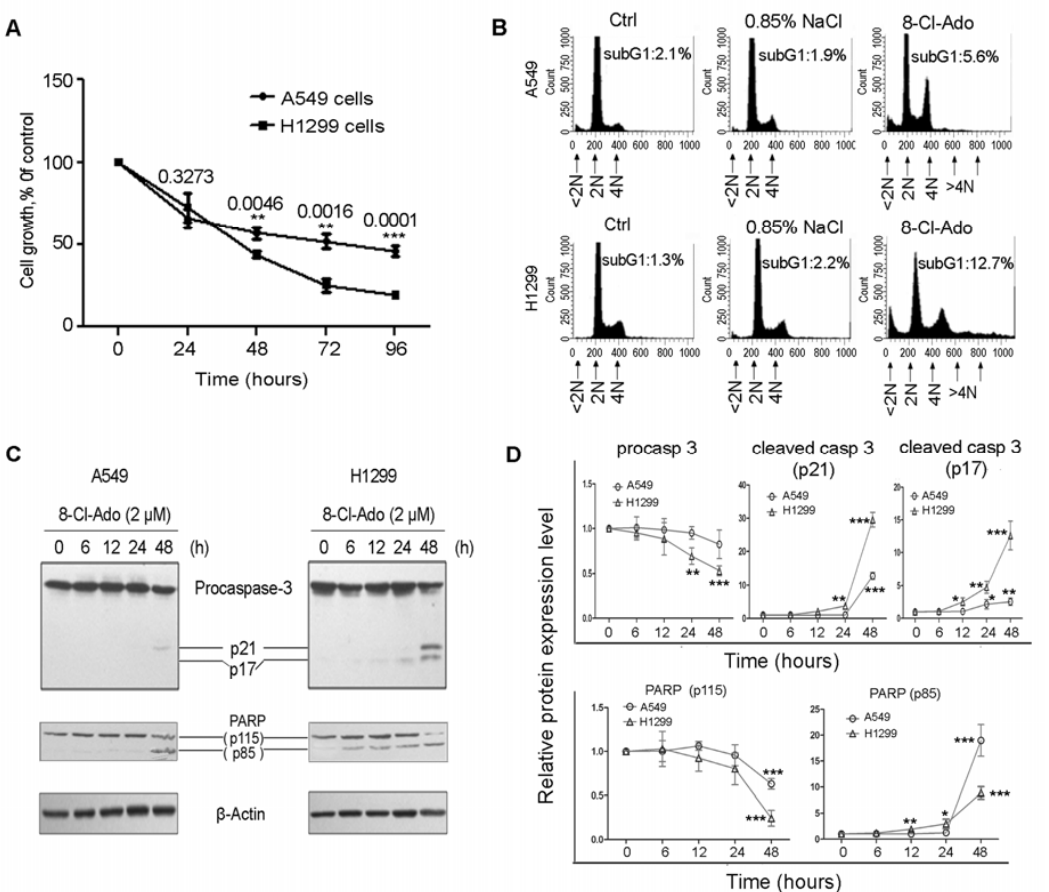
Figure 1. Effects of 8-Cl-Ado on cell growth and apoptosis. A549 and H1299 cells were exposed to 2 µ M 8-Cl-Ado for indicated hours. ( A ) Cell proliferation was evaluated with MTT assay (see materials and methods). Data represent mean ± SD ( n = 3); ( B ) cells exposed to 8-Cl-Ado for 48 h were stained with propidium iodide whose signal was measured by FACScan. Apoptotic cells (subG1/<2N) were assayed by the computer program CELLQuest. Data are representative of three independent experiments; ( C ) a representative Western blotting for Procaspase-3 activation and PARP-1 cleavage in 8-Cl-Ado-exposed cells. β -Actin as a loading control; ( D ) relative levels of Procaspase-3, Procaspase-3-cleaved fragments (p21 and p17), PARP-1 (p115) and its cleaved product (p85) in Western blotting. The blots were screened/quantified with the software Quantity One (Bio Rad) and normalized against β -Actin level, and the ratio of target protein to Actin from control (0 h exposure) cells was designated as “1” (100%). Data represent mean ± SD ( n = 3). * p < 0.05; ** p < 0.01; *** p < 0.001.